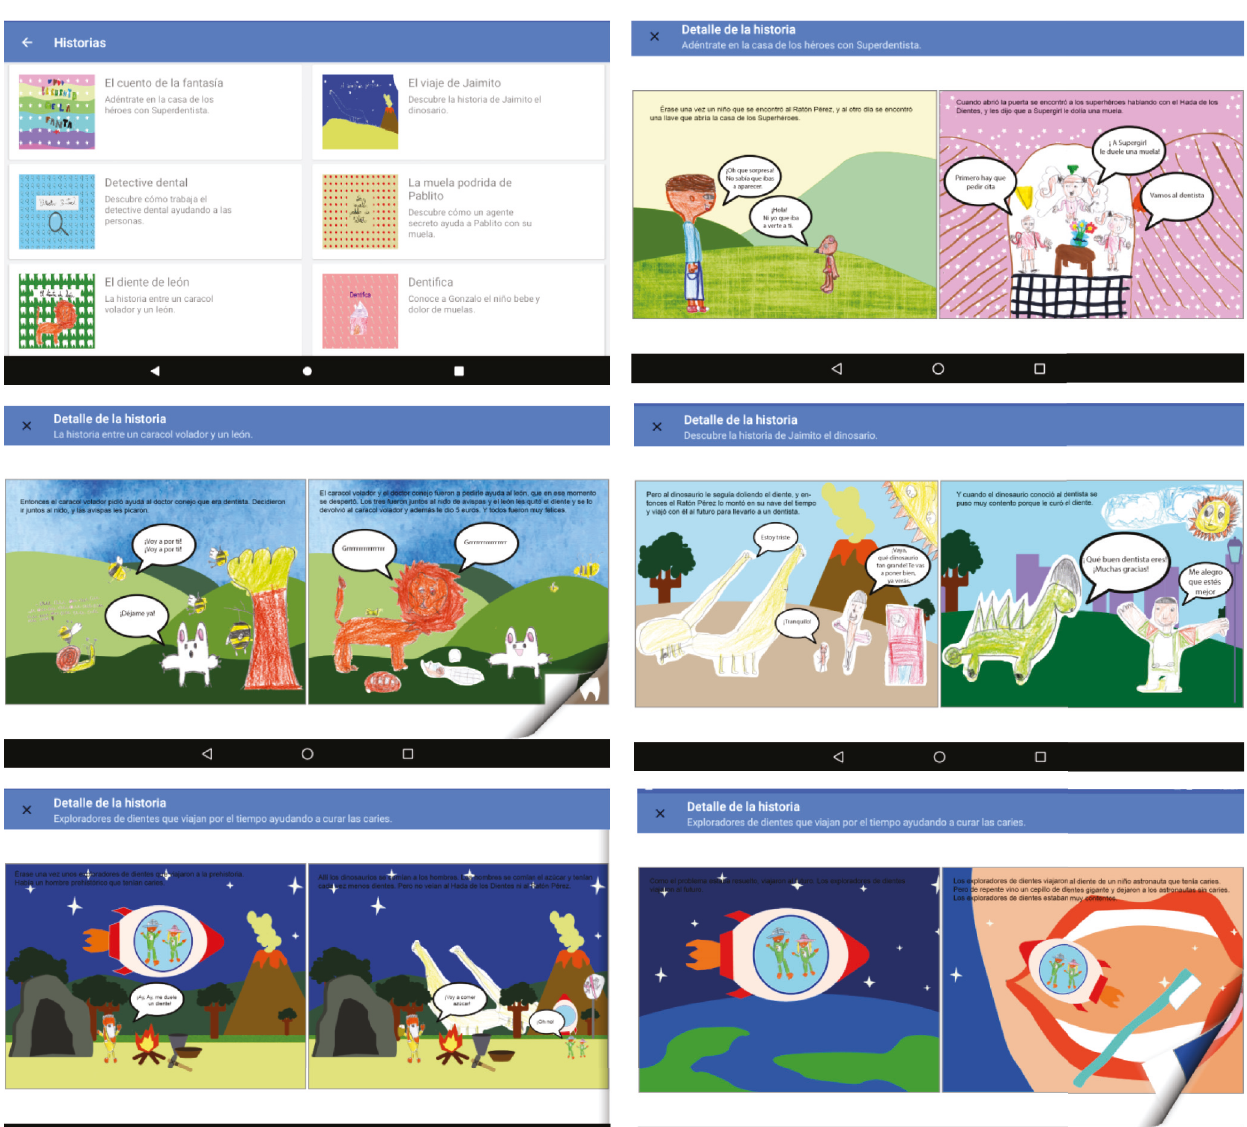
Figure 26: Narrative menu and